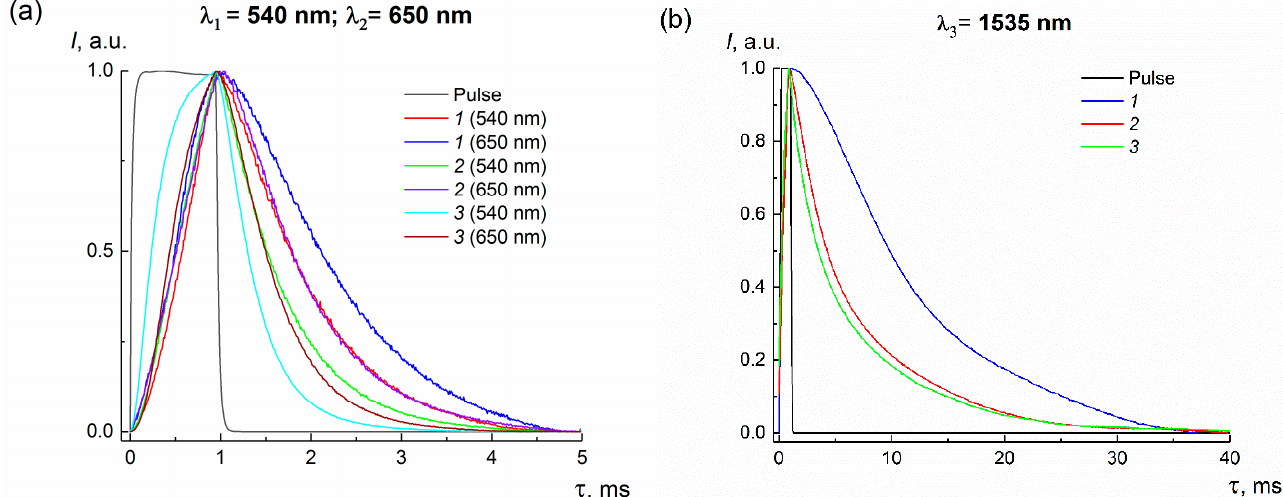
Figure 8. Decay curves of luminescence emission bands in ( a ) visible and ( b ) IR spectral ranges of